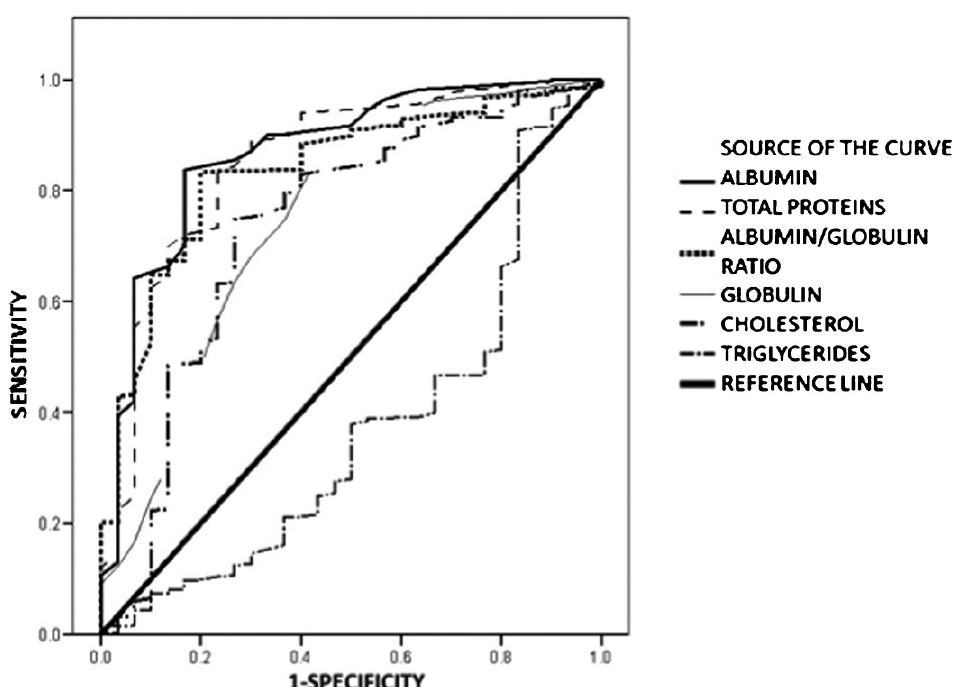
Figure 1 - Receiver-operating characteristic (ROC) curves. Albumin=0.861, total protein=0.853, albumin/globulin ratio=0.837, globulin=0.755, cholesterol=0.734, and